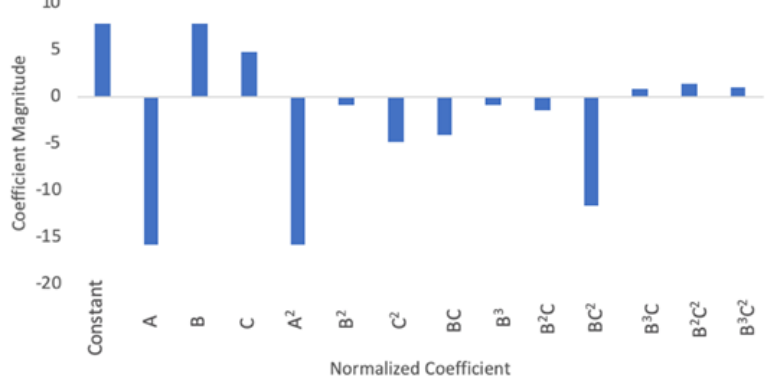
Figure 11. Phenomenological response model coefficients.